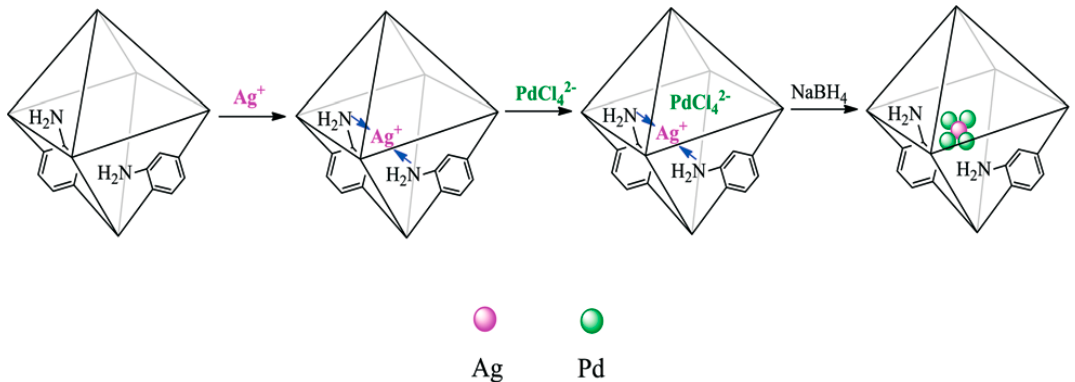
Figure 7. Schematic representation of the synthesis process of the AgPd@NH 2 -UiO-66. Reprinted with permission from [85].